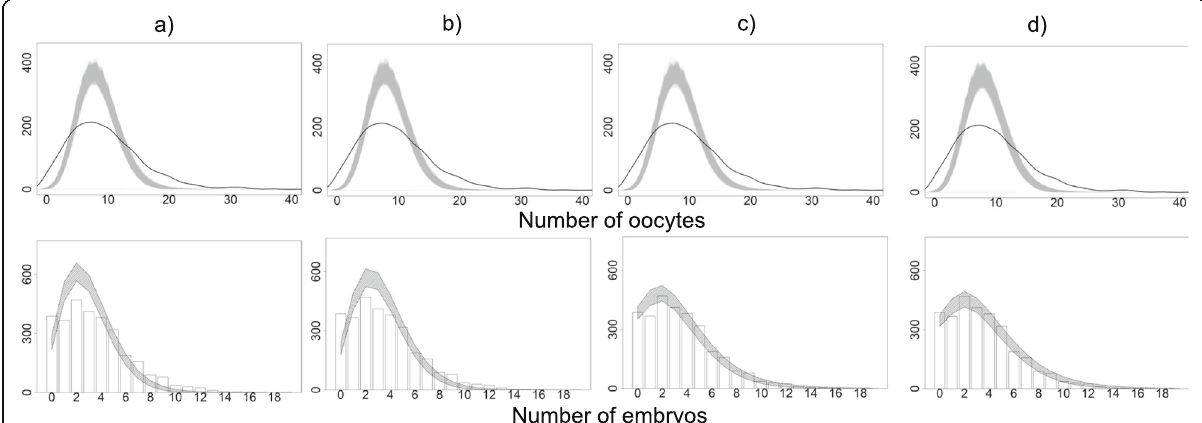
Fig. 2 95% posterior predictive intervals (shaded area) for number of oocytes and number of embryos, obtained from a ) pre-treatment separate, b ) pre-treatment joint, c ) dynamic separate, d ) dynamic joint models, plotted with observed stage-specific